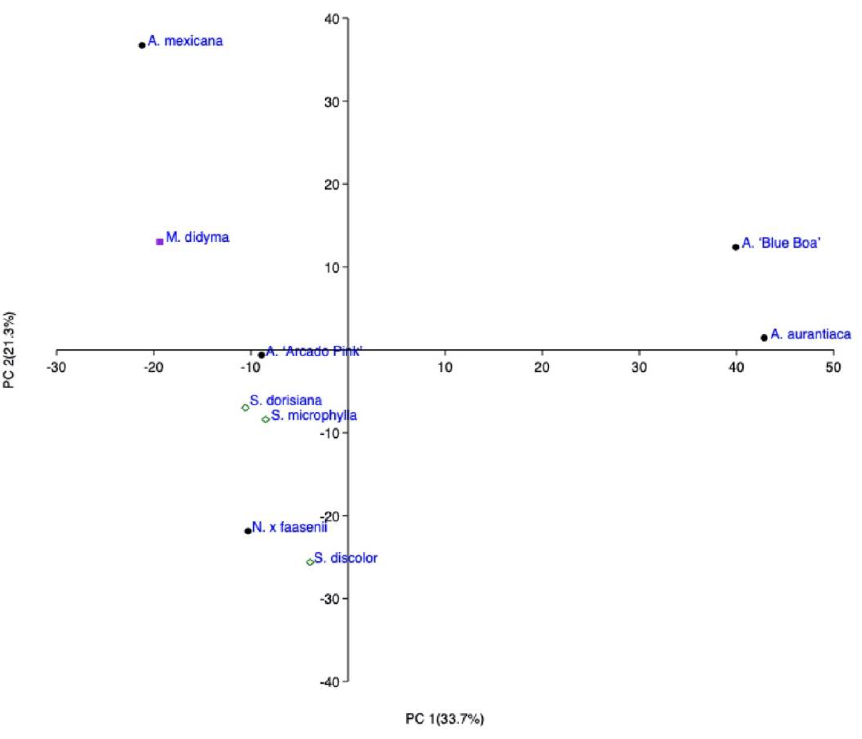
Figure 1. Principal Cluster Analysis (PCA) of the spontaneous emission of the plants belonging to the Mentheae tribe.